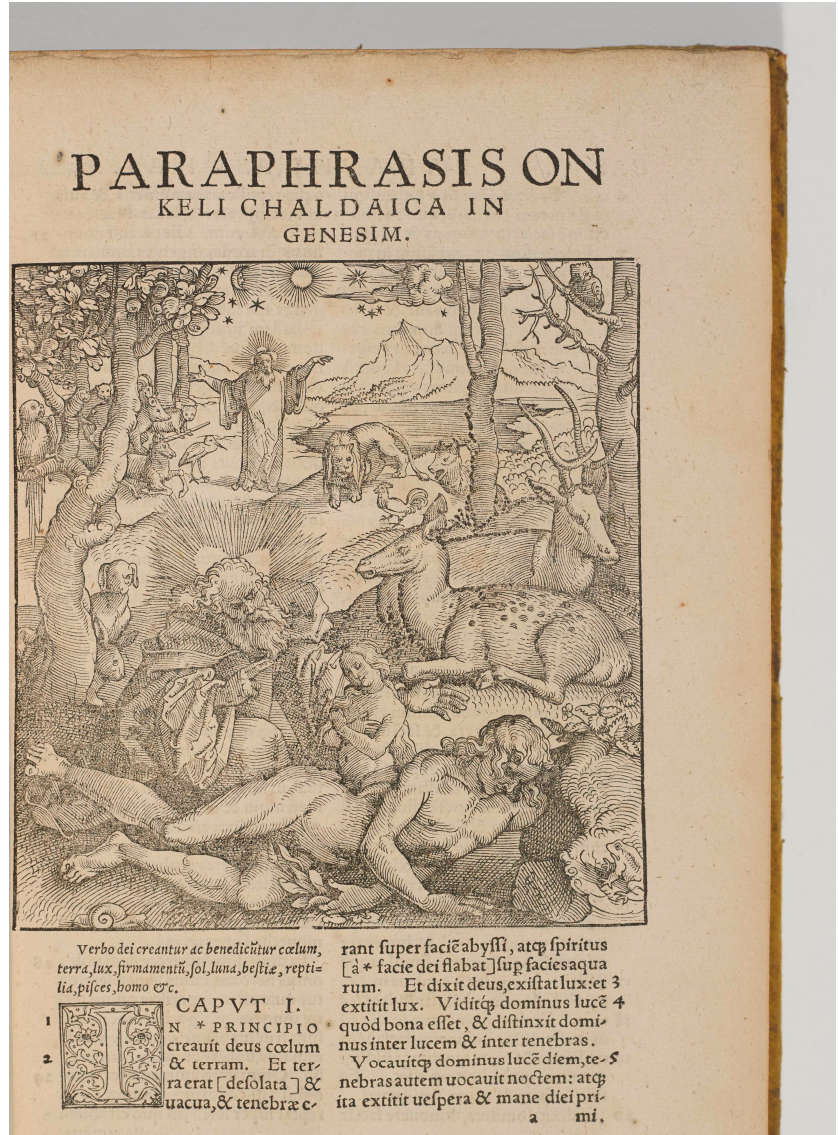
Figure 15. Targum translation in Latin; Marsh’s Library R.5.3.23 (Bouhéreau collection).